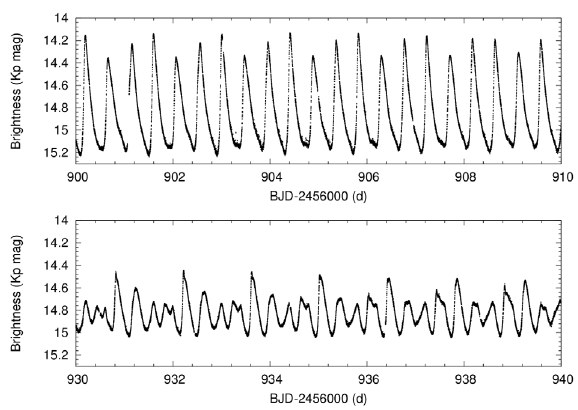
Figure 2: Di ff erent sections of the light